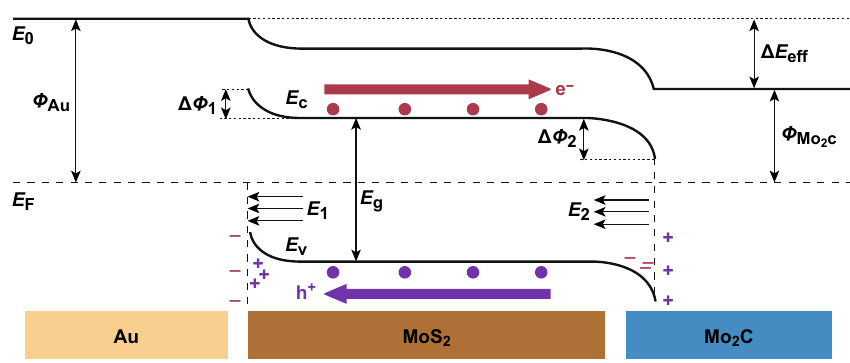
Fig. 6 Schematic band energy diagram of the Mo 2 C/MoS 2 /Au device